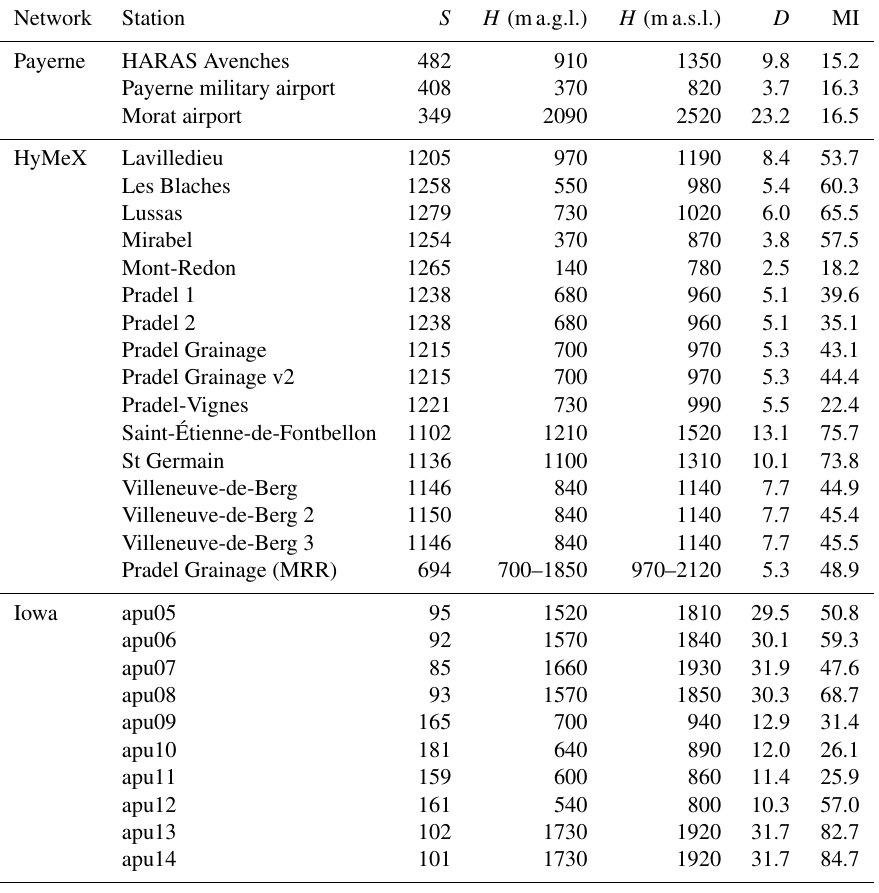
Table 2. Instrument stations with corresponding PPI volumes, with the number of scans for that volume ( S ), the volume centre’s height above the ground ( H , ma.g.l., to nearest 10m), height above sea level ( H , ma.s.l., to nearest 10m), and horizontal range from the radar ( D , km). MI (mmh − 1 ) is the maximum 1min rain intensity recorded by each instrument at a radar scan